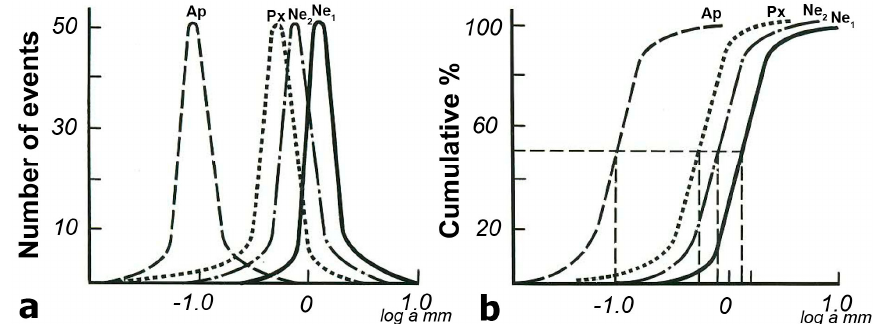
Figure 8. ( a ) Distribution diagrams for various minerals; ( b ) Calculated cumulative diagrams for minerals. Ap—apatite from rich apatite ore; Px—clinopyroxene from lenticular-banded and net- like